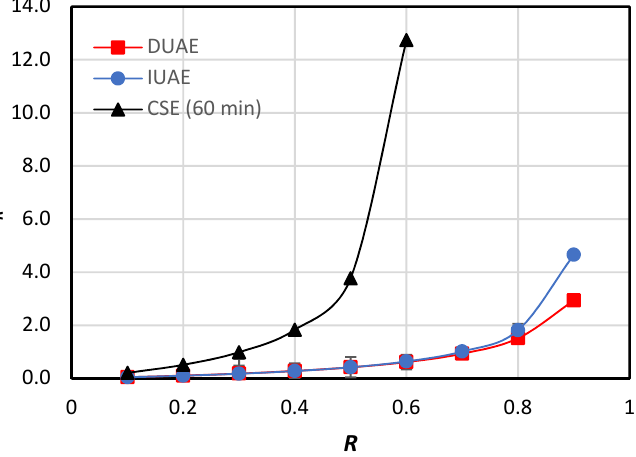
Figure 3. Time, t R , required to achieve a given recovery ratio, R , of phenolic compounds from potato peels for the three methods used in the present study. t R is calculated using Equation (6) and data given in Table 1 assuming that C Max = 9.0 mg GAE/g dry wt.